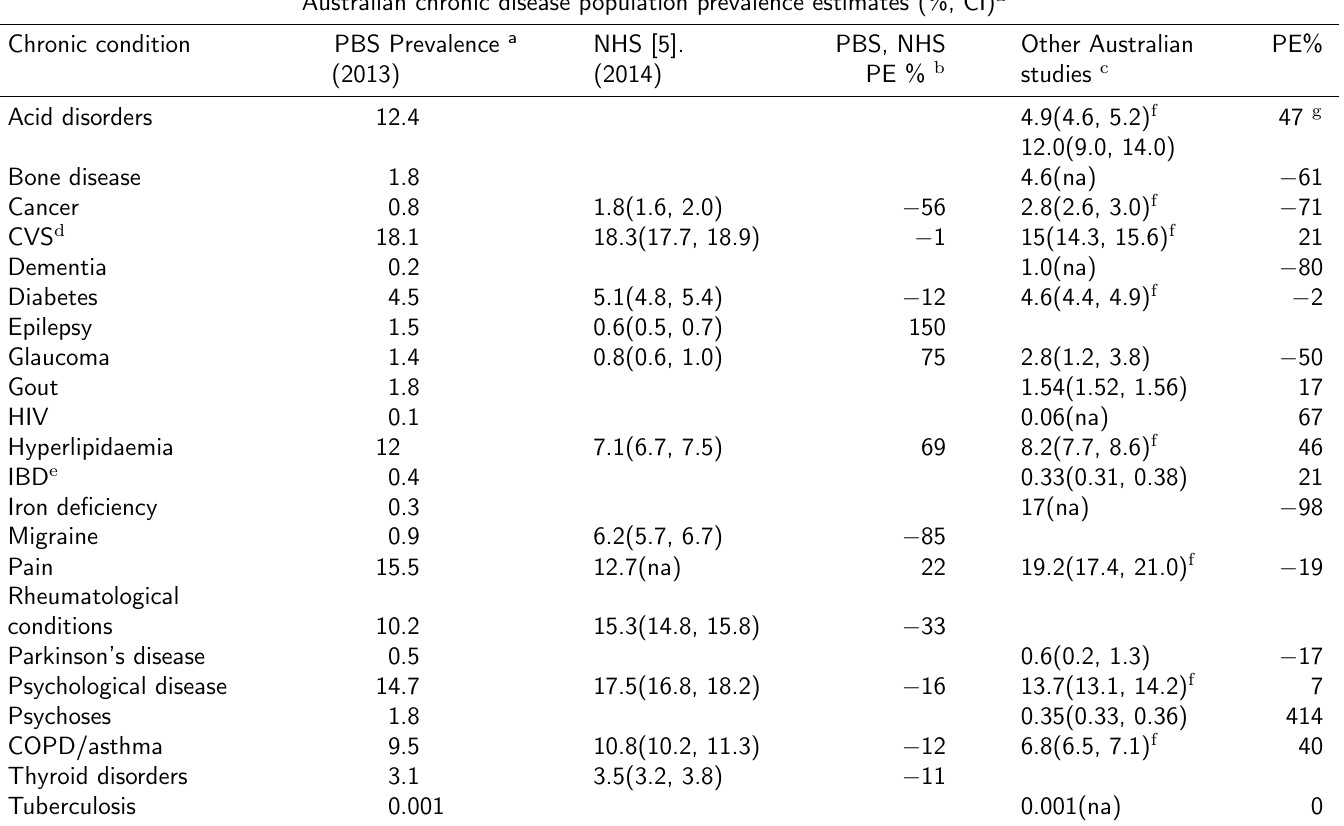
Table 3: Comparisons of Australian population chronic disease prevalence estimates using Pharmaceutical Benefits Scheme data with Australian community